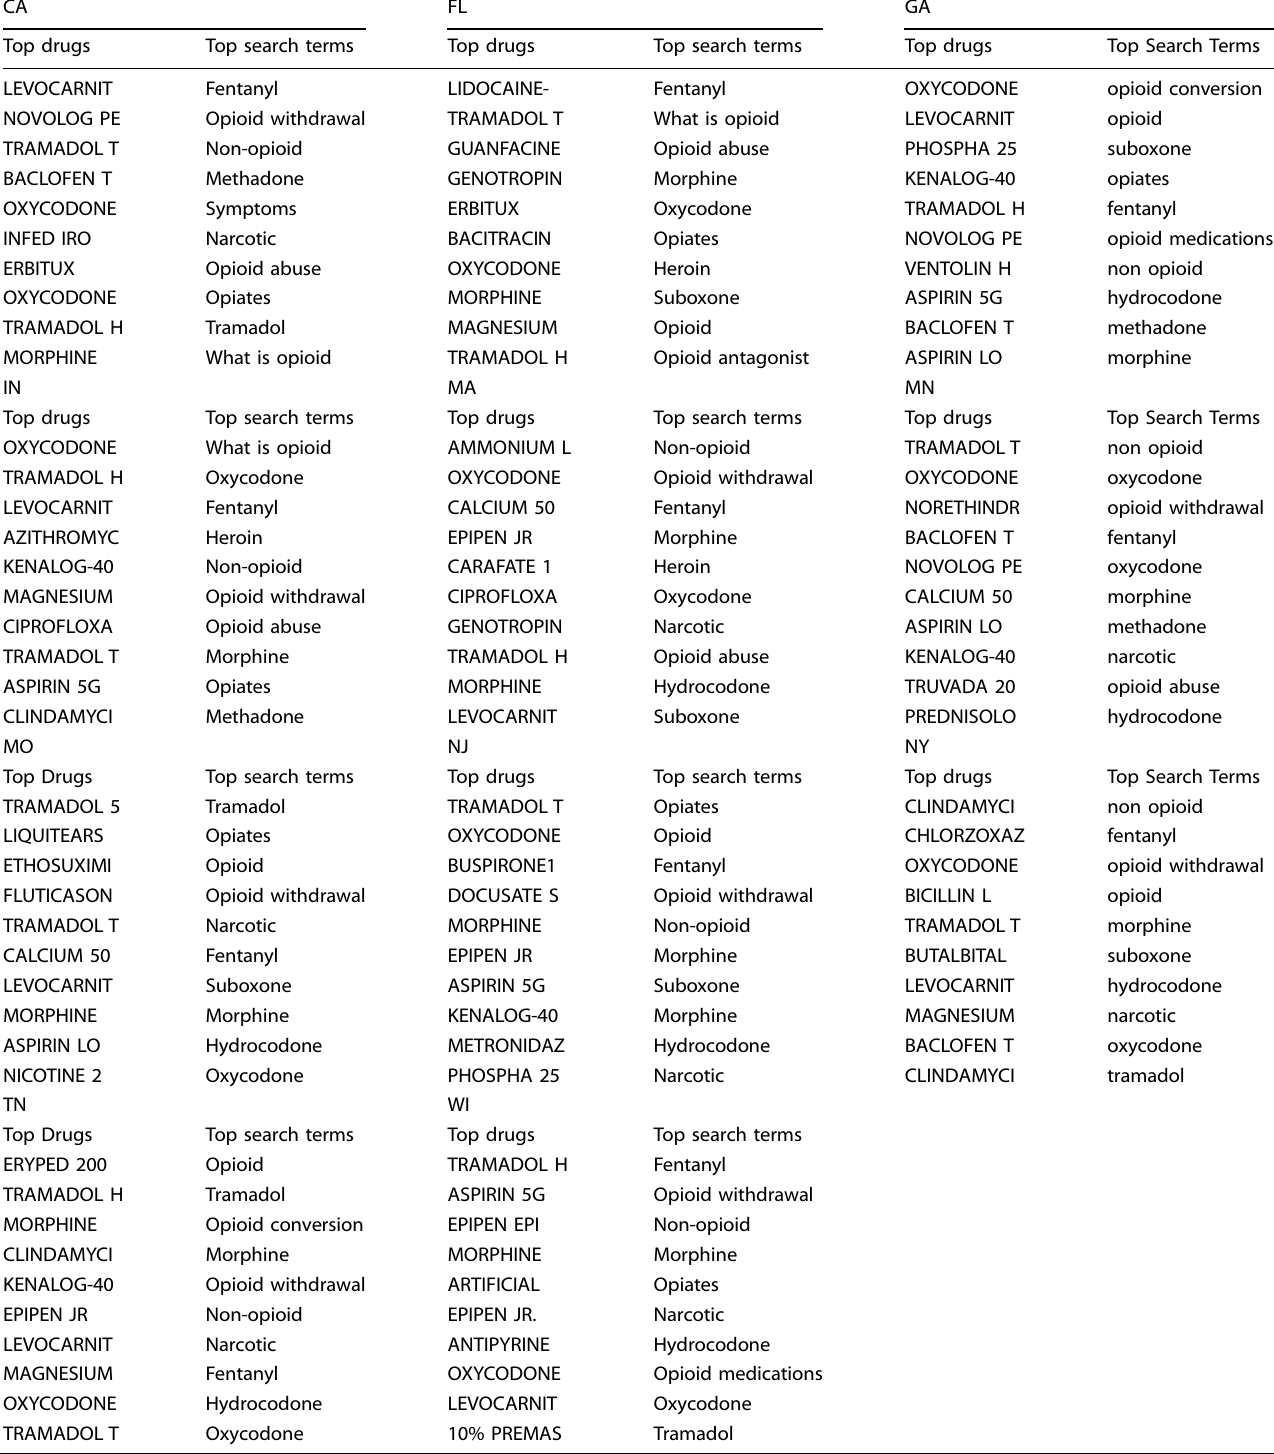
Table 2. Opioid-related prescribed drugs and Google search terms for each